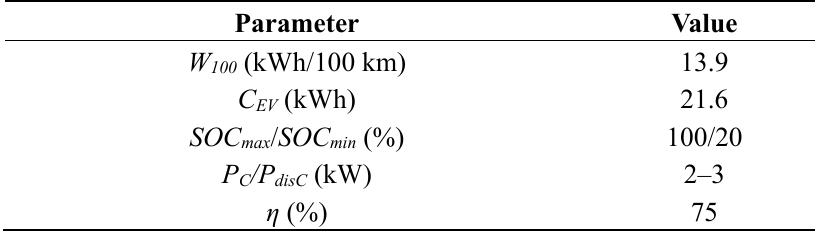
Table 2. Parameters of EV.